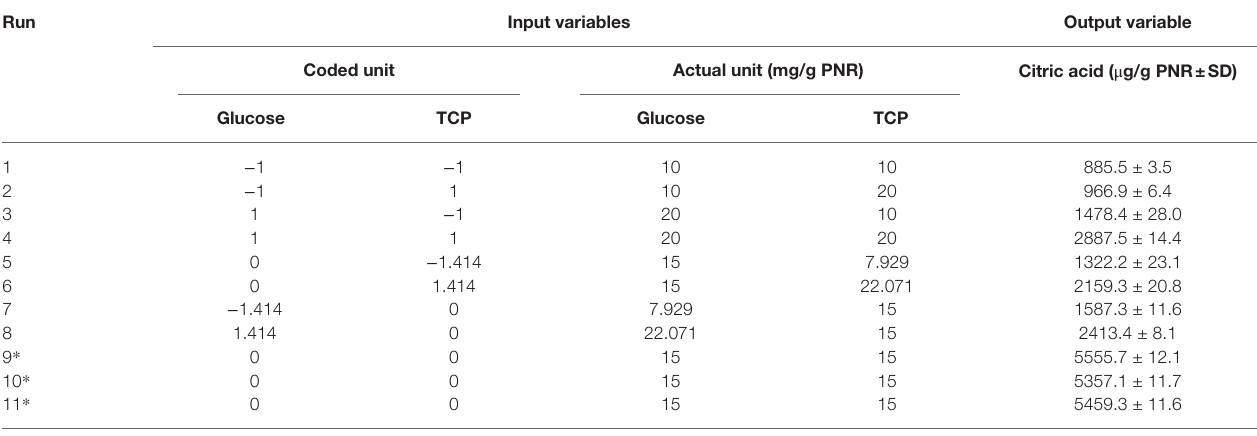
TABLE 2 | Values of CA levels detected by HPLC based on the central composite design (CCD) matrix of the studied variables (glucose and TCP) on the PNR-based medium fermented by Trichoderma sp. WKA55.